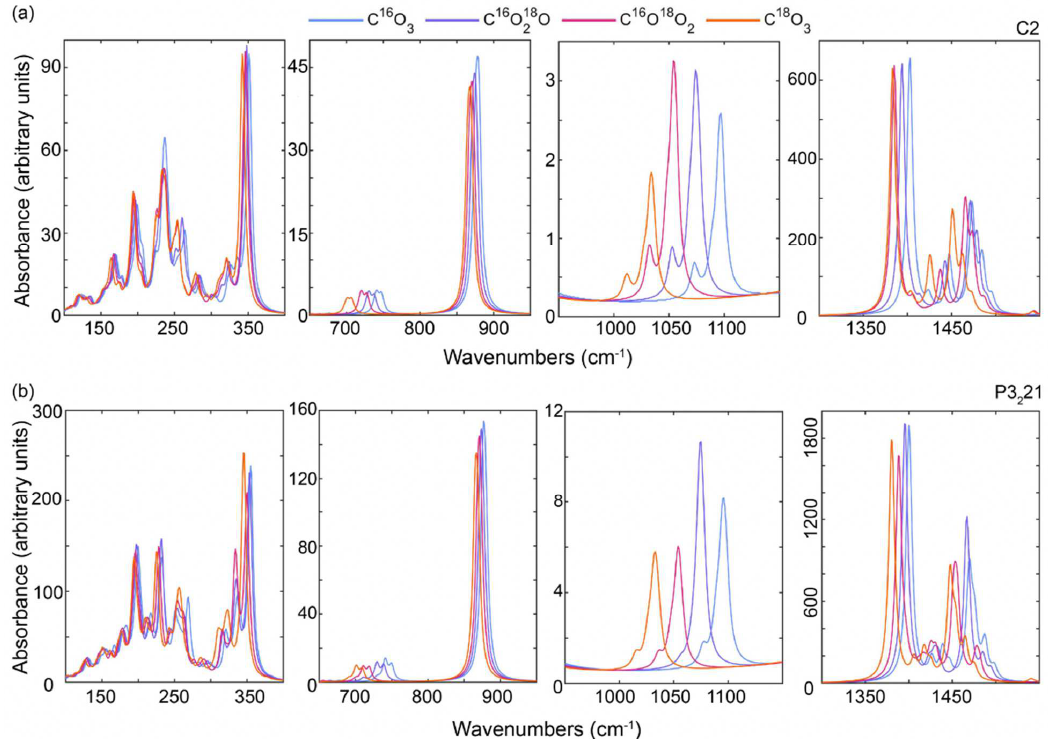
Figure 2. Calculated IR spectrum of vaterite with each of the four carbonate O − isotopologues: ( a ) C2 structure, ( b ) P3 2 21 structure. The regions outside of the plotted areas have no vibrational bands visible. Note that the individual regions of interest are plotted with different y axes to facilitate visualization.